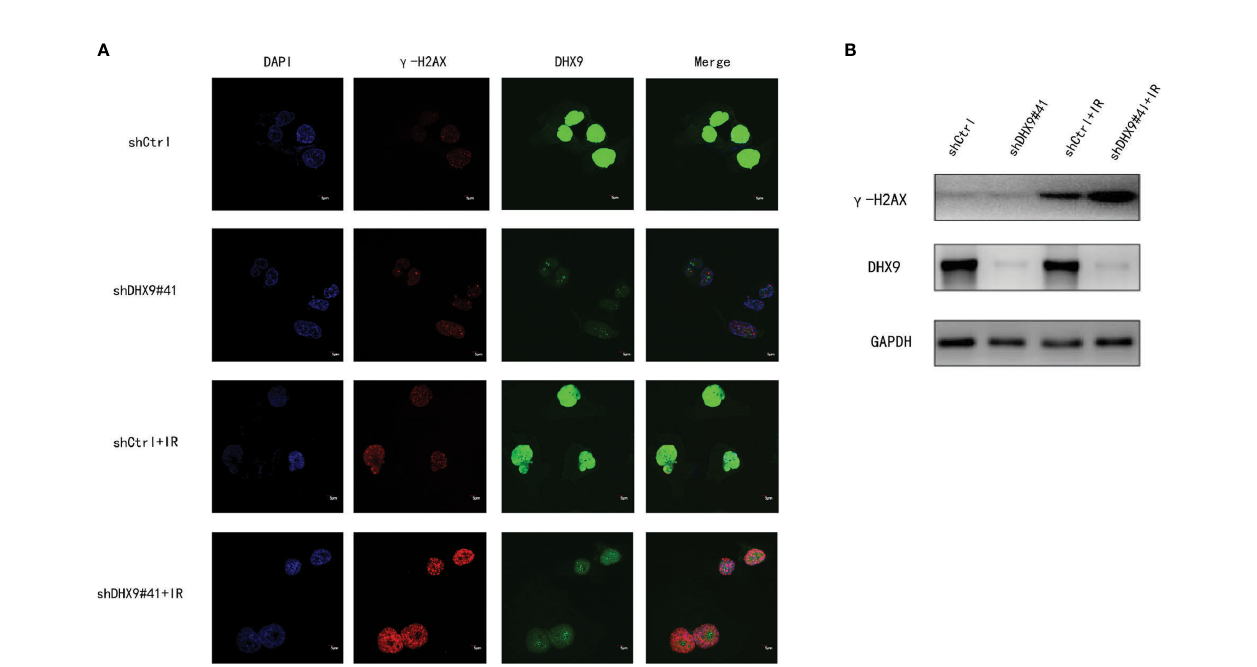
FIGURE 7 | Effect of DHX9 on DNA damage repair in Hep-3B cells. (A) Representative fl uorescence images of g -H2AX (red) and DHX9 (green) immunostaining in Hep-3B cells (scale bar: 5 m m). Nuclei were stained with DAPI (blue). (B) Western blot analysis of g -H2AX expression in Hep-3B cells. DAPI, 4 ’ ,6-diamidino-2-